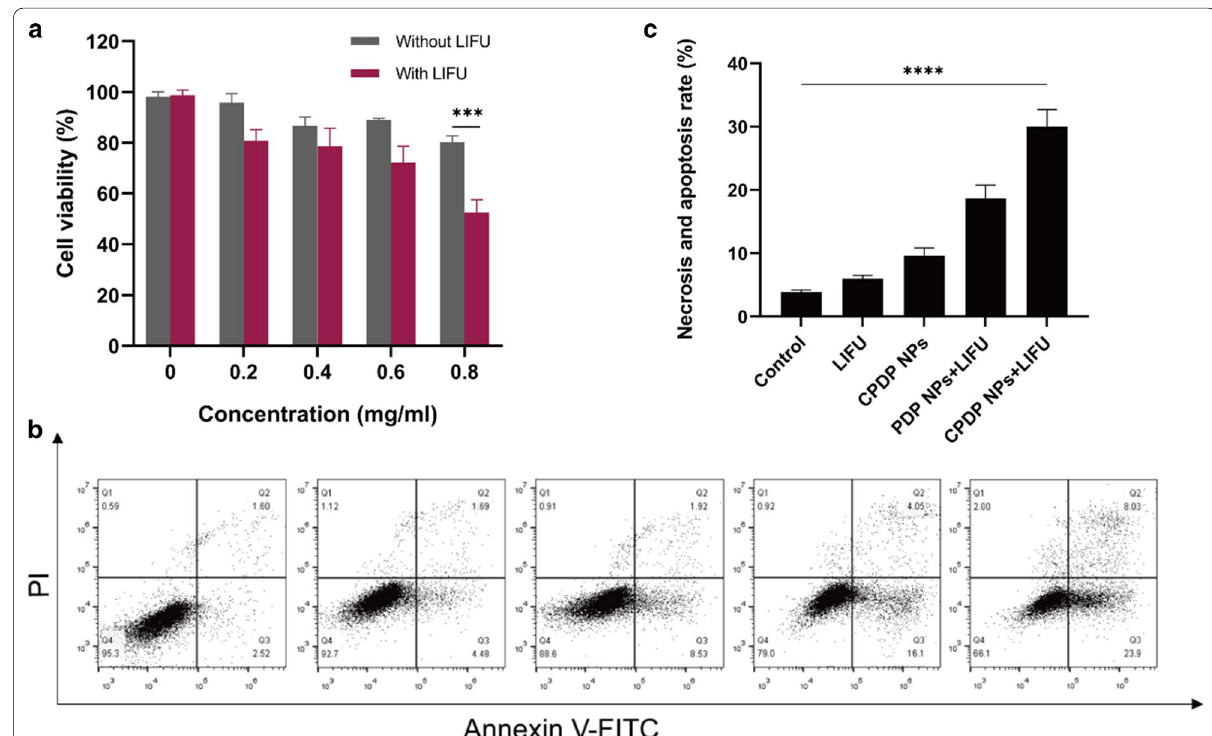
Fig. 5 a Relative cell viability with or without LIFU irradiation under different CPDP NPs concentrations. b 4T1 tumor cell apoptosis and necrosis by flow cytometry assay and c the data of corresponding necrosis and apoptosis rate analysis (**** p < 0.0001, *** p < 0.001, n